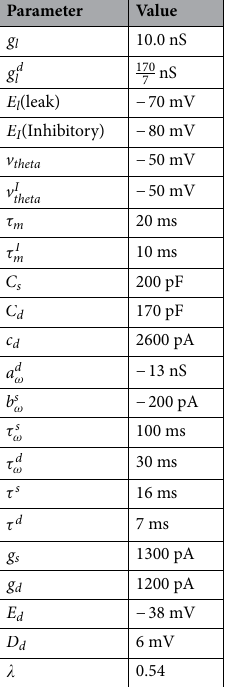
Table 2. Parameters of the neuron